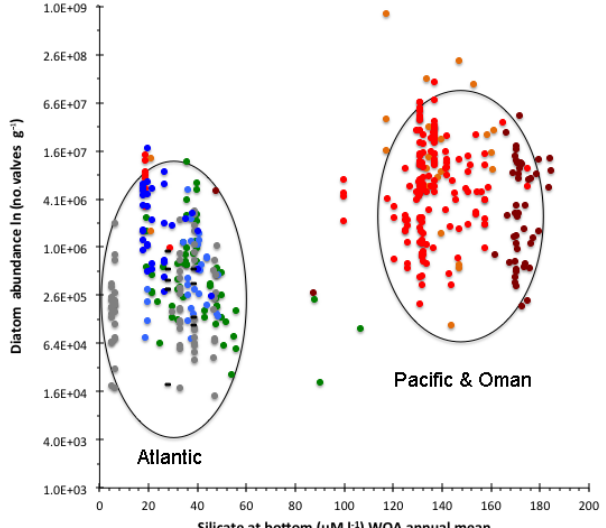
Figure 3. Relationship between total marine diatom abundance ln (no. of valvesg − 1 ) and bottom-water [Si(OH) − ] in µM from the 4 WOA 2009 database. Color scheme as in Fig.